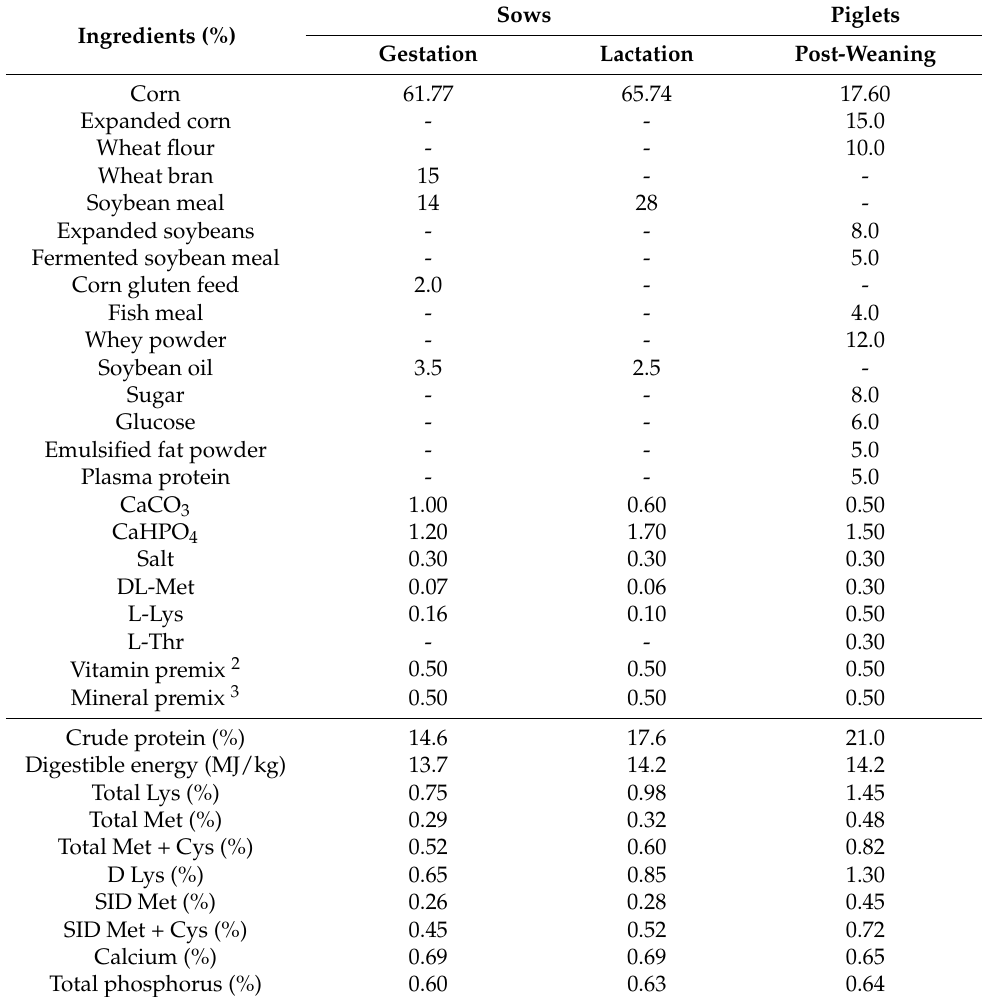
Table 1. Ingredients and nutrients composition 1